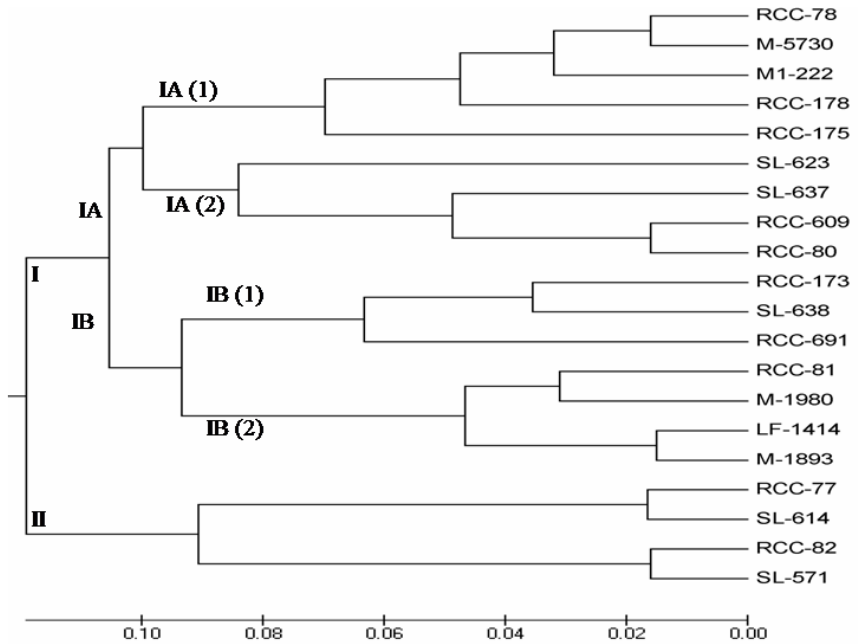
Figure 4. The unweighted pair group method of analysis (UPGMA) dendrogram based on summarized data regarding differentiation among experimental